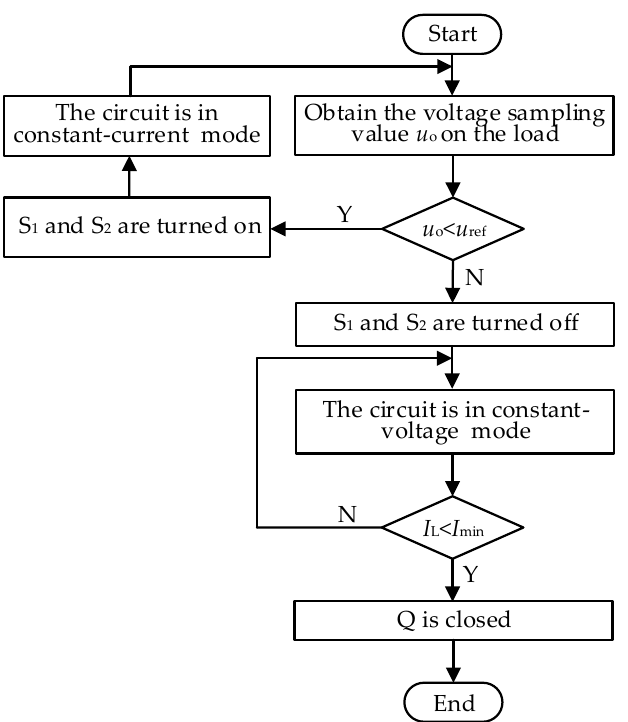
Figure 19. Control flowchart of the proposed WPT system for the CC and CV modes.